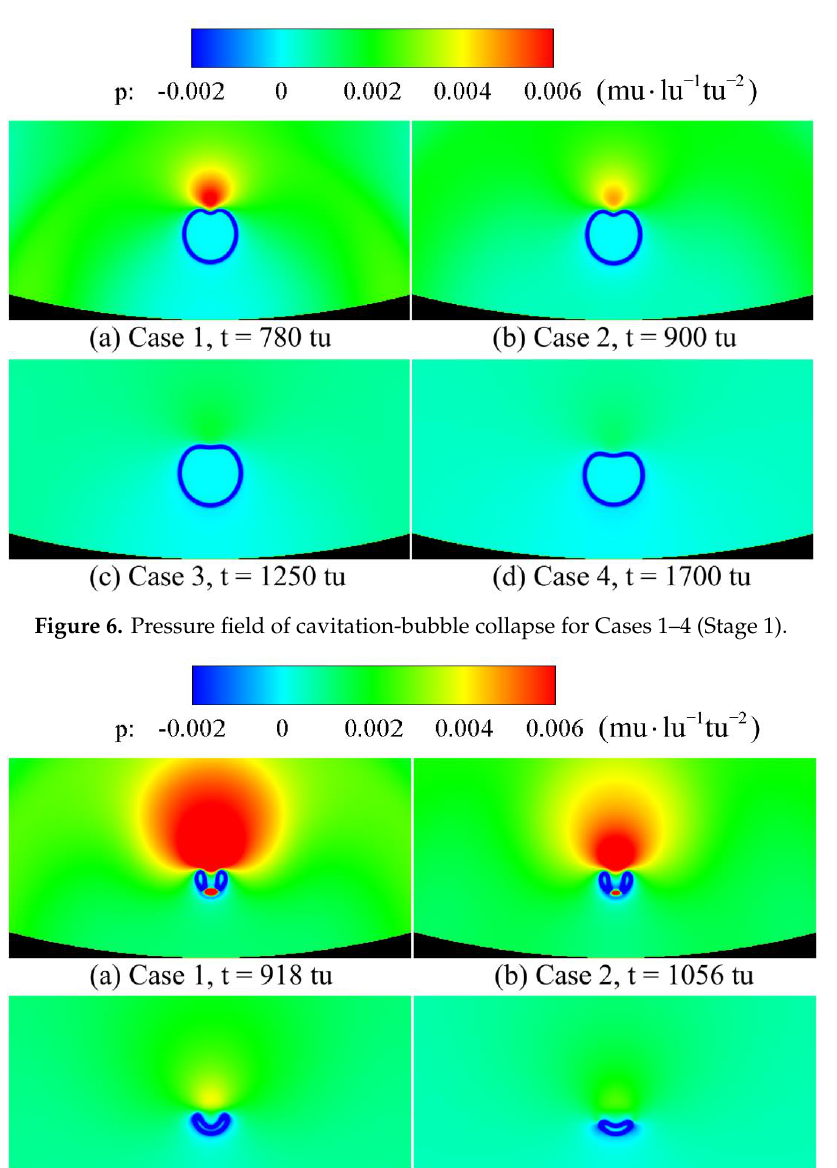
Table 1. Used parameters in Cases 1–4.